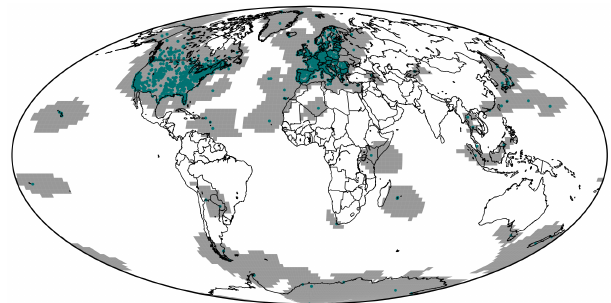
Figure 2. Map of surface ozone observational coverage based on the composite of the footprints for existing background ozone observ- ing sites. Blue markers indicate site locations, and the gray areas their